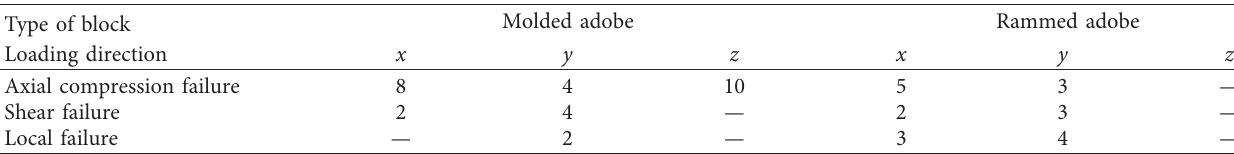
Figure 3: Failure modes of full-size blocks. In each picture, the molded adobe is shown on the left, and the rammed adobe is shown on the right. (a) Axial compression failure, (b) shear failure, and (c) local failure. Table 5: Distribution of failure